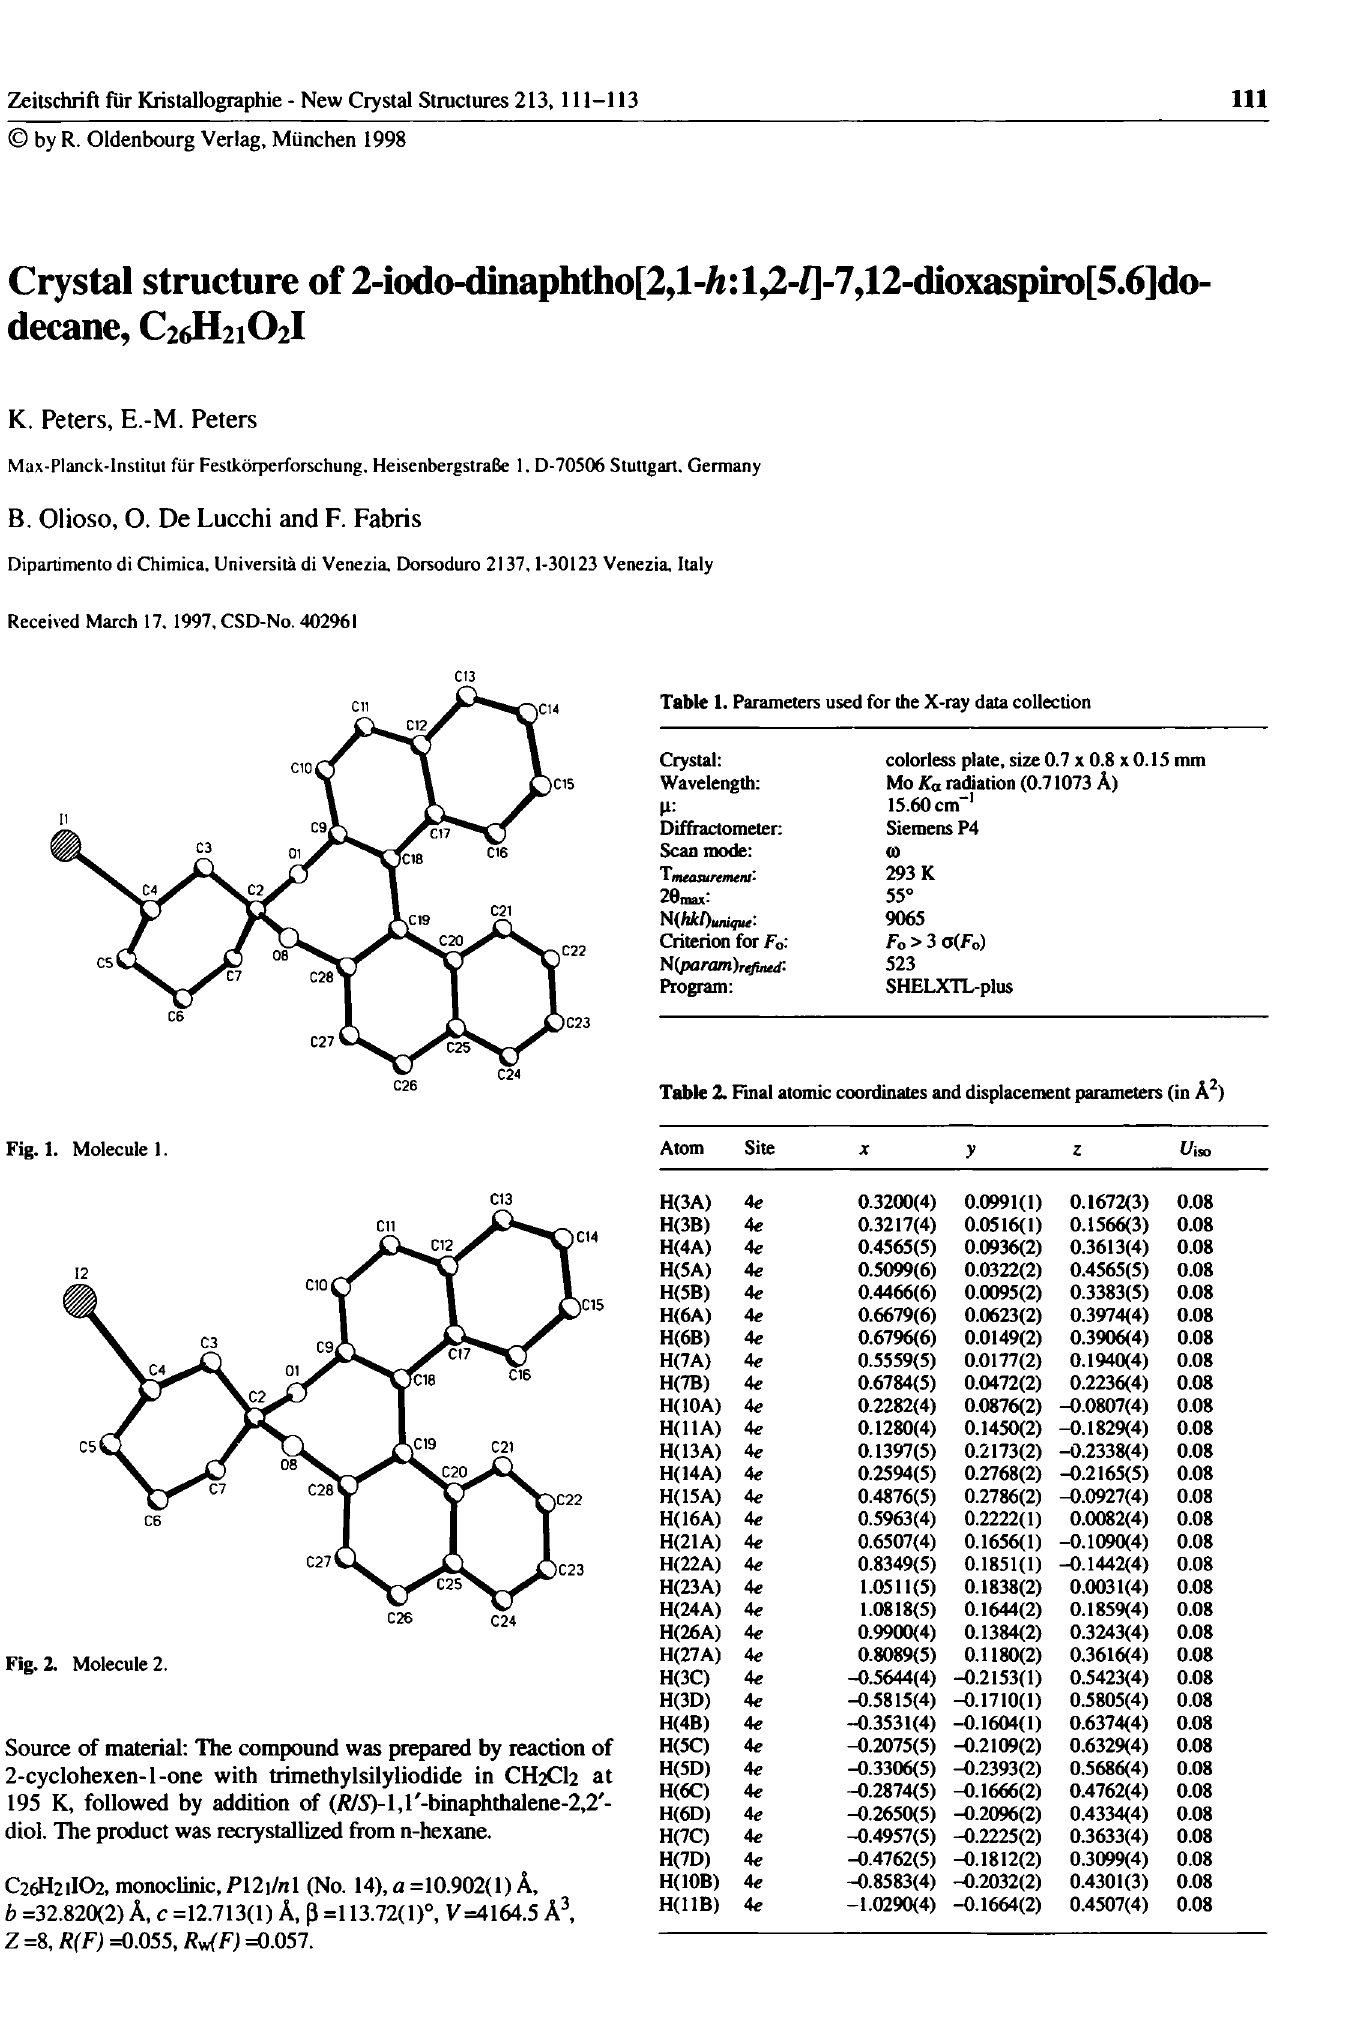
C26H21IO2, monoclinic, P\2\ln\ (No. 14), a =10.902(1) Â,